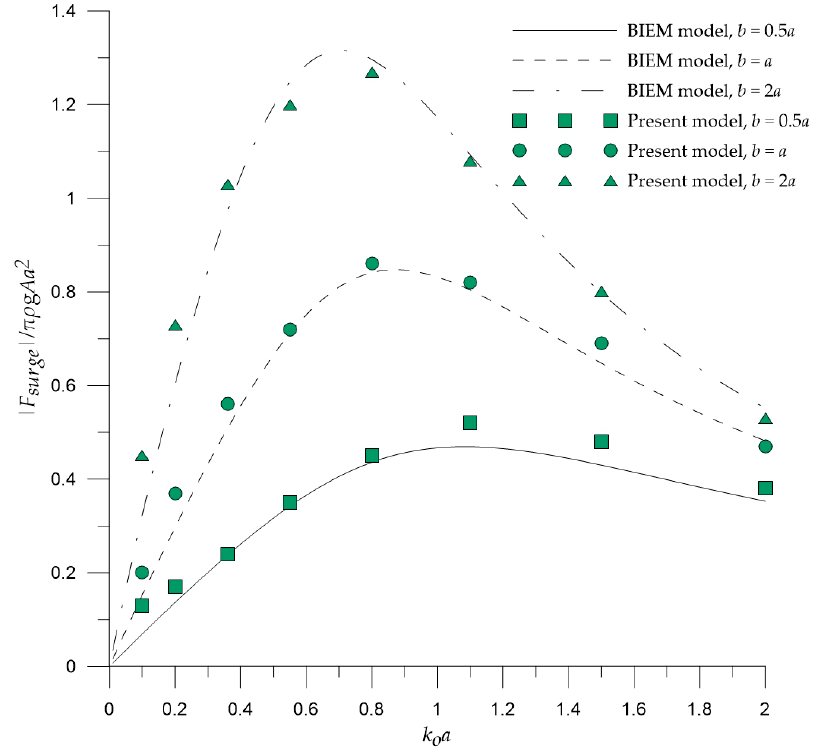
(cid:12) (cid:12) Figure 1. Variation of (cid:12) F surge (cid:12) / πρ gAa 2 as a function of k o a for different b / a ratios (fixed Figure 1. Variation of (cid:3627)𝐹 (cid:3046)(cid:3048)(cid:3045)(cid:3034)(cid:3032) (cid:3627)/ 𝜋𝜌𝑔𝐴𝑎 (cid:2870) as a function of 𝑘 (cid:3042) 𝑎 for different 𝑏/𝑎 ratios (fixed circu- circular cylinder). lar cylinder).